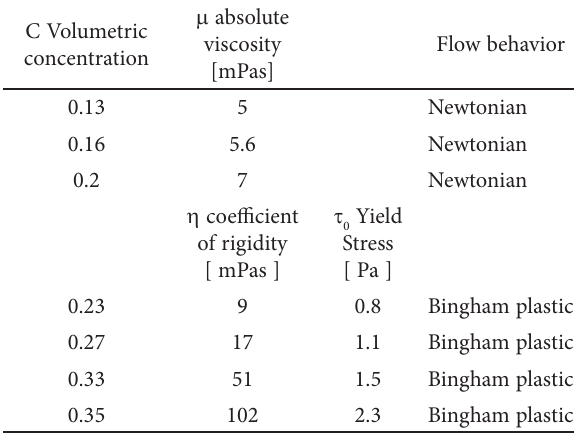
Table 4. Flow properties of Mátra Power Plant, Fly Ash: